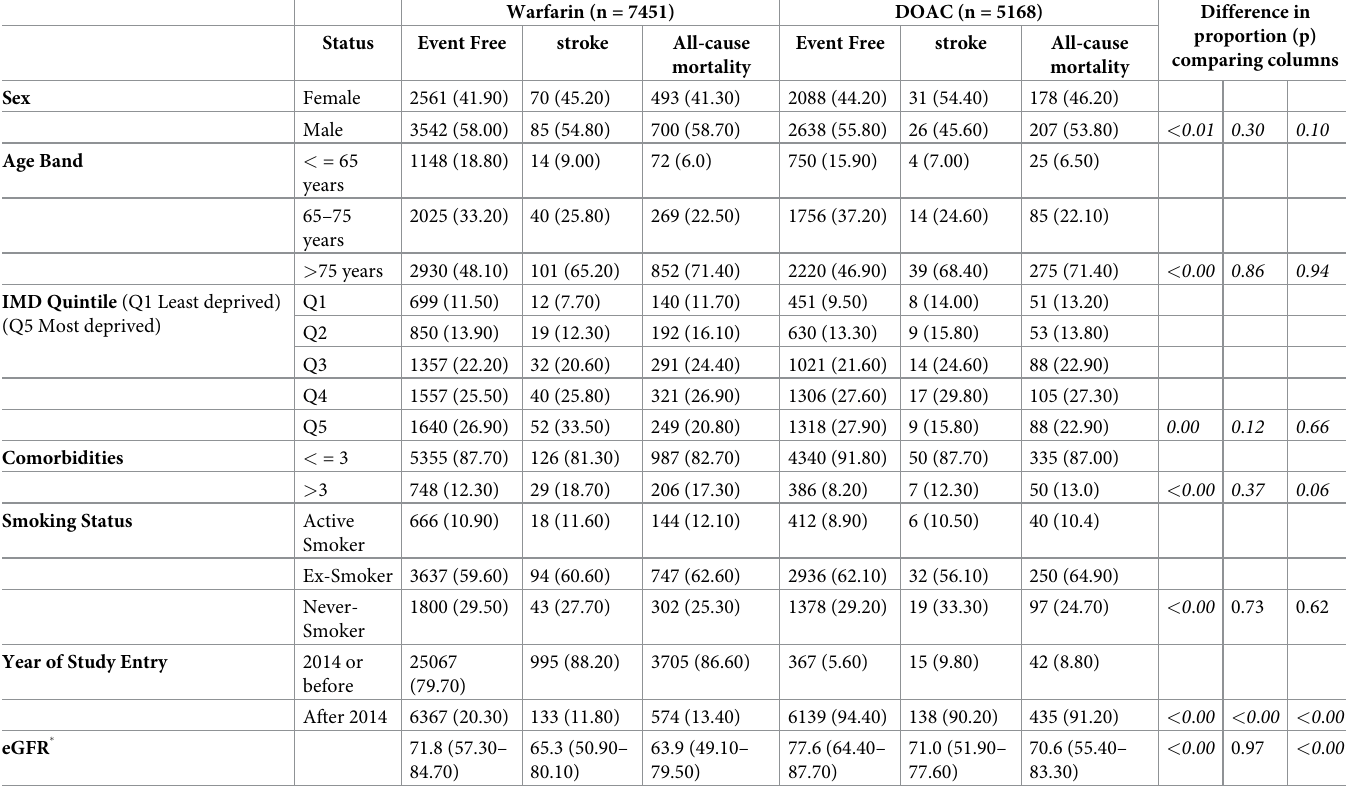
Table 1. Baseline characteristics of study cohort (n, %) showing the probability of any differences between event free, stroke and all-cause mortality groups between those exposed to Warfarin or DOACs. Warfarin (n = 7451) DOAC (n = 5168) Difference in proportion (p) columnsStatus Event Free stroke All-cause Event Free stroke All-cause comparing mortality